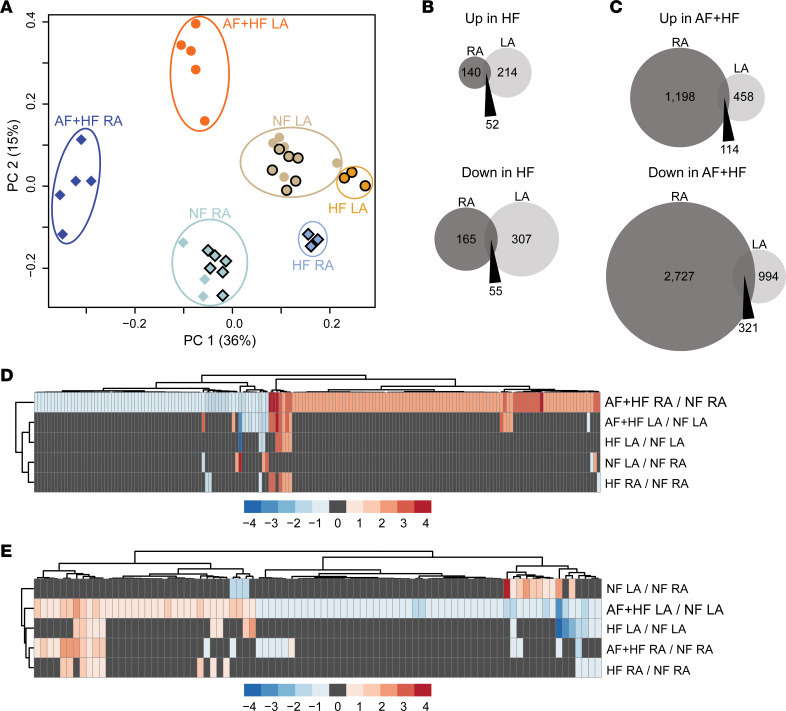
Chamber-specific transcriptomic differences in human atrial fibrillation cardiomyocyte nuclei.RNA-sequencing was performed on isolated cardiomyocyte nuclei (CMN) from human right atrium (RA) and left atrium (LA) from nonfailing (NF) donor hearts rejected for transplantation with no history of atrial fibrillation (AF), explanted hearts from individuals with end-stage heart failure (HF) who received a heart transplant without a history of AF, and end-stage heart failure with a documented history of AF (AF+HF). (A) Principal components analysis (PCA) plot showing the distribution of variance among all human samples (NF RA, light teal; AF+HF RA, dark blue; HF RA, light blue; NF LA, brown; AF+HF LA, bright orange; HF LA, orange). Venn diagrams representing the number of differentially upregulated (top) and downregulated (bottom) transcripts in the human RA or LA CMN with (B) HF or (C) AF+HF when compared with NF controls. (D) Heatmap with color scale showing the relative expression levels (Z score; red, up; blue, down) of transcription factors (TFs) differentially expressed in AF+HF RA when compared with NF RA. Relative expression levels of the same TFs are shown for each of the other group comparisons, including AH+HF LA compared with NF LA, HF LA compared with NF LA, HF RA compared with NF RA, as well as a comparison of NF LA to NF RA. (E) Similar heatmap analysis as shown in D, except the TFs shown are those differentially expressed in AF+HF LA when compared with NF LA. RNA-sequencing performed sequentially on 2 batches: batch 1: symbols with black outline on PCA, n = 9 individual RA (n = 6 NF, n = 3 HF) and n = 9 individual LA (n = 6 NF, n = 3 HF). Batch 2: symbols without black outline on PCA, n = 8 individual RA (n = 3 NF, n = 5 AF+HF) and n = 10 individual LA (n = 5 NF, n = 5 AF+HF). Transcripts with a fold change threshold of no more than 0.667 or at least 1.5 and false discovery rate (FDR) less than 0.05 were considered statistically significant.